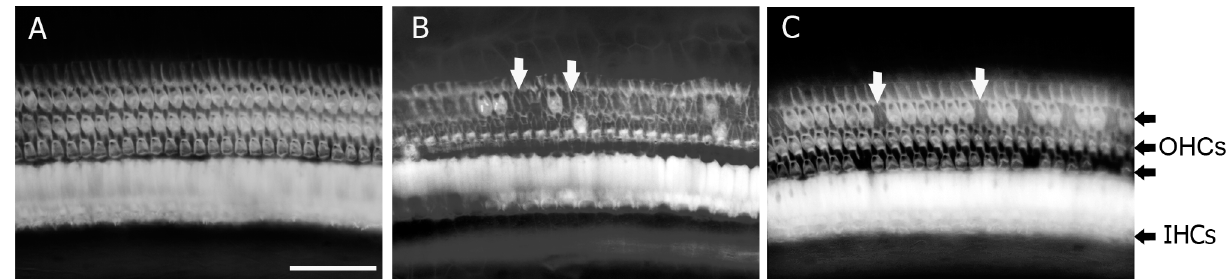
Fig 8. Representative photomicrographsof cochlear hair cells after phalloidinstainingat about 70% of the distance from the apex in normal (na ï ve)(A), and control (untreated)(B) and treated chinchillaat 21 days after the blast exposure. Arrows show examplesof missing outer hair cells (OHC) that have been replacedby scars. Scale bar = 50 μ m.